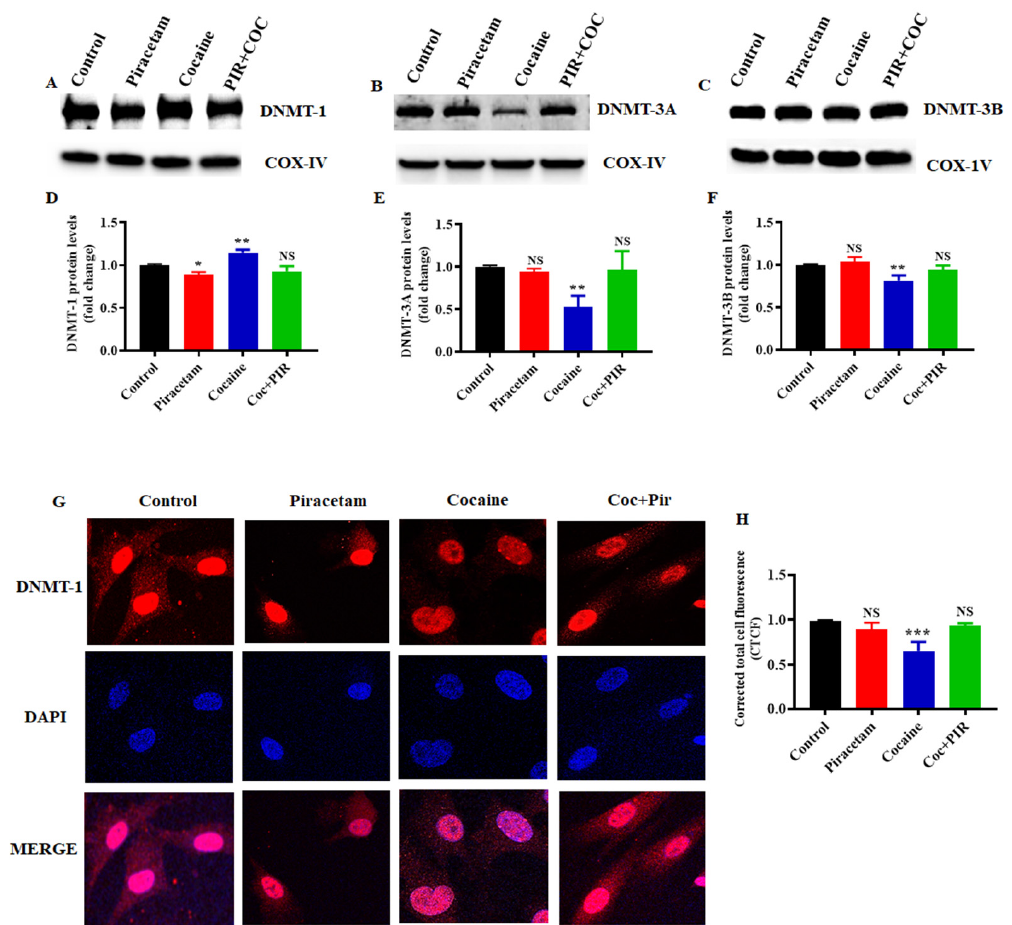
Figure 3. Piracetam reversed the impact of cocaine on DNMT protein expression in the mitochondrial fraction. Human primary astrocytes (5 × 10 6 cells / mL) were exposed to cocaine (1 µ M) and / or piracetam (10 µ M) for 24 h. Mitochondrial fraction were resolved by SDS-PAGE and analyzed by western blots showing the expression of ( A ) DNMT-1, ( B ) DNMT-3A and ( C ) DNMT-3B. ( D – F ) Densitometric analysis of the level of each protein relative to the level of COX-IV as a loading control (fold change relative to the control). The data are expressed as the mean ± SD of three independent experiments. *** p < 0.001, ** p < 0.01, * p < 0.05, NS—nonsignificant. ( G ) DNMT-1 immunostaining (red) and cell nuclei, which were stained with DAPI (blue), were observed by confocal microscopy (magnification 100x, scale bar 100 µm). ( H ) Quantification of DNMT-1 fluorescence intensity (CTCF).